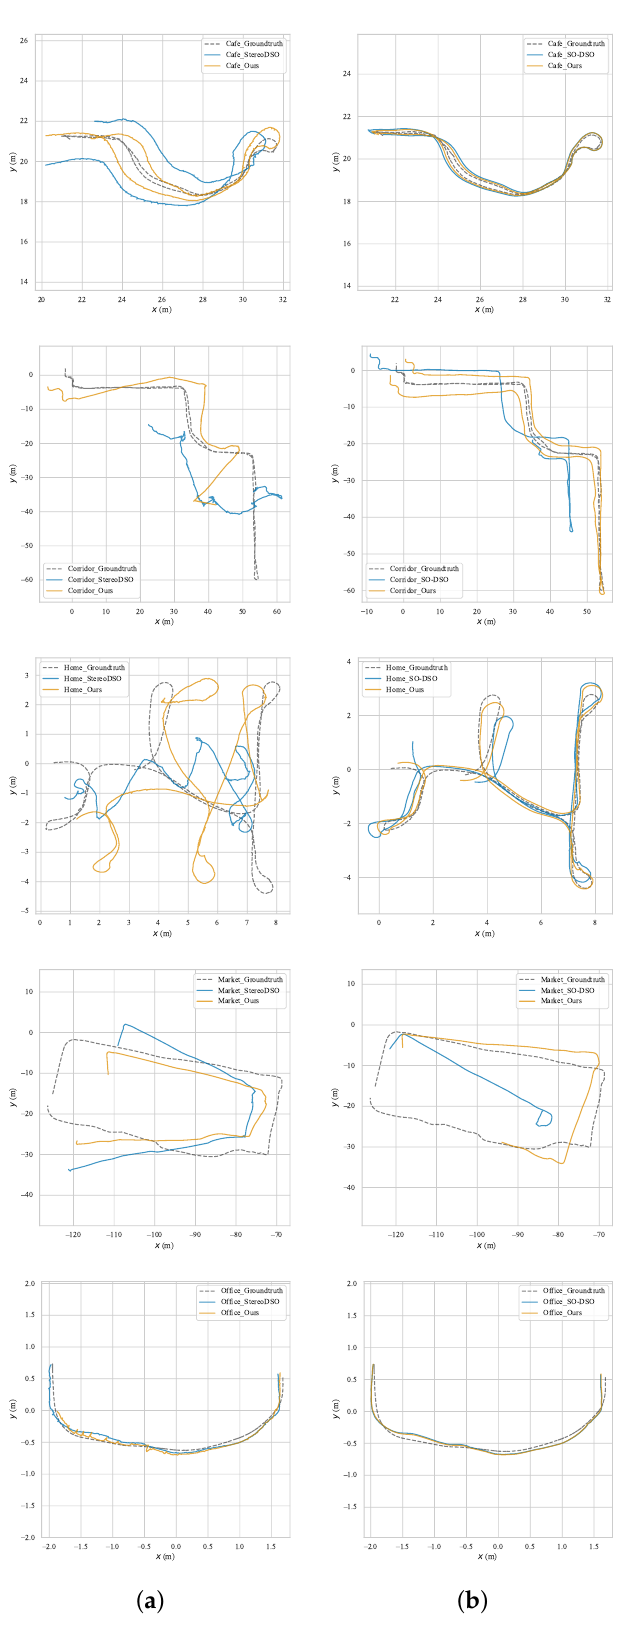
Figure 5. The experimental results on OpenLORIS-Scene dataset. ( a ) Trajectories by Stereo DSO with and without the proposed method. ( b ) Trajectories by SO-DSO with and without the pro- posed